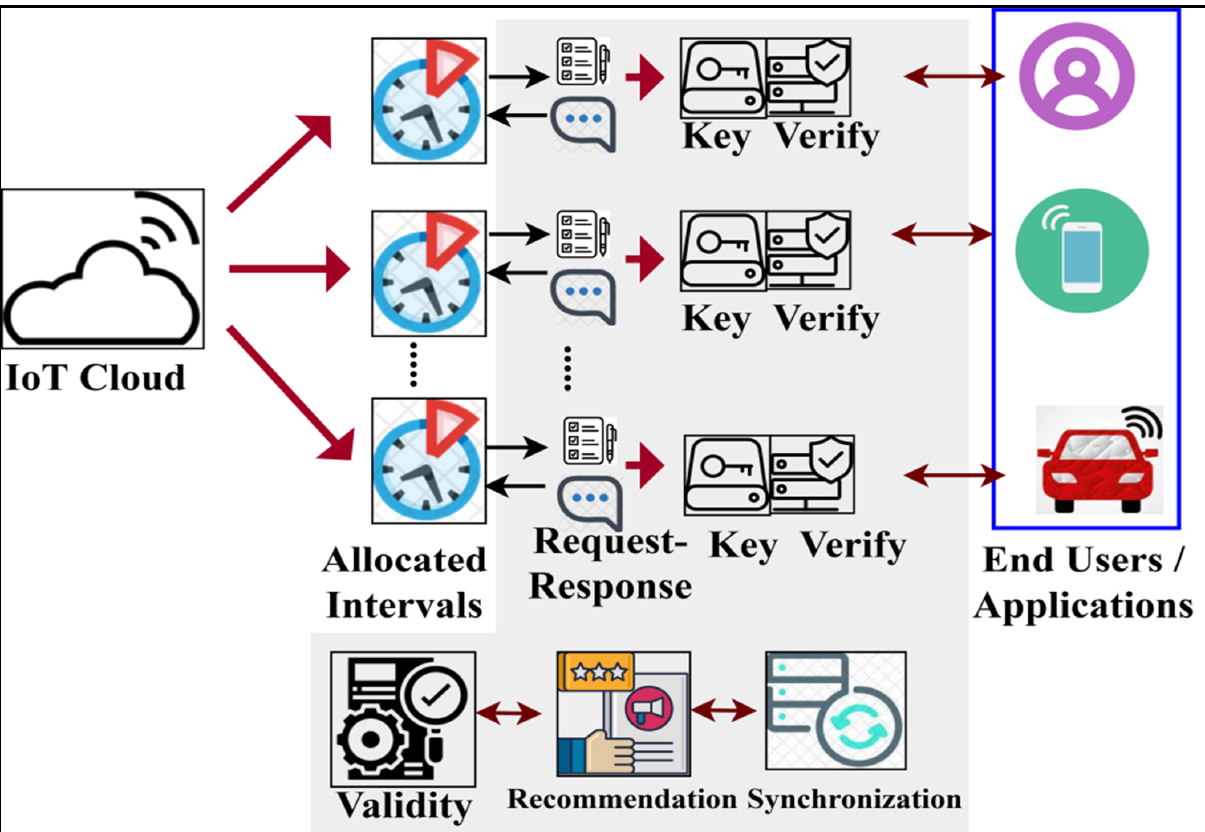
Figure 1. Proposed permuted security framework in IoT environment.